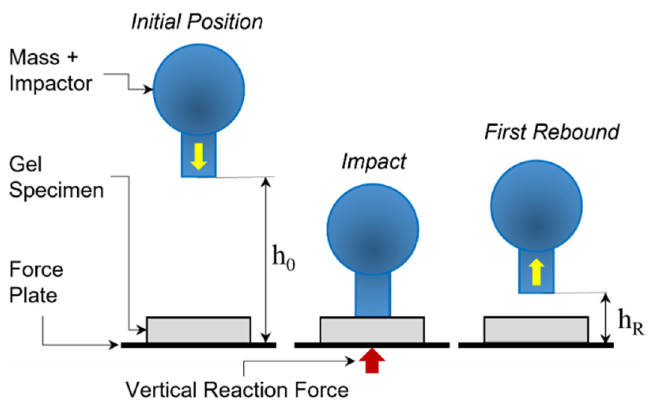
Figure 4. Schematics of impact